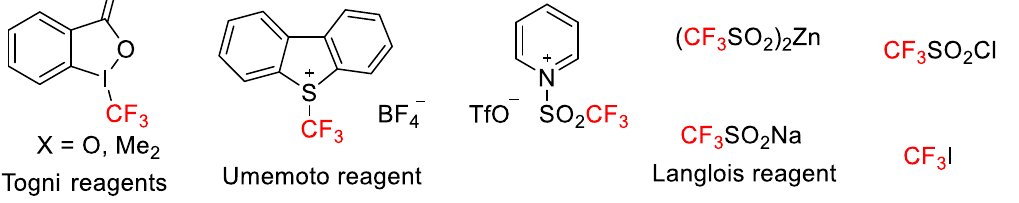
Figure 1. Trifluoromethylating reagents.